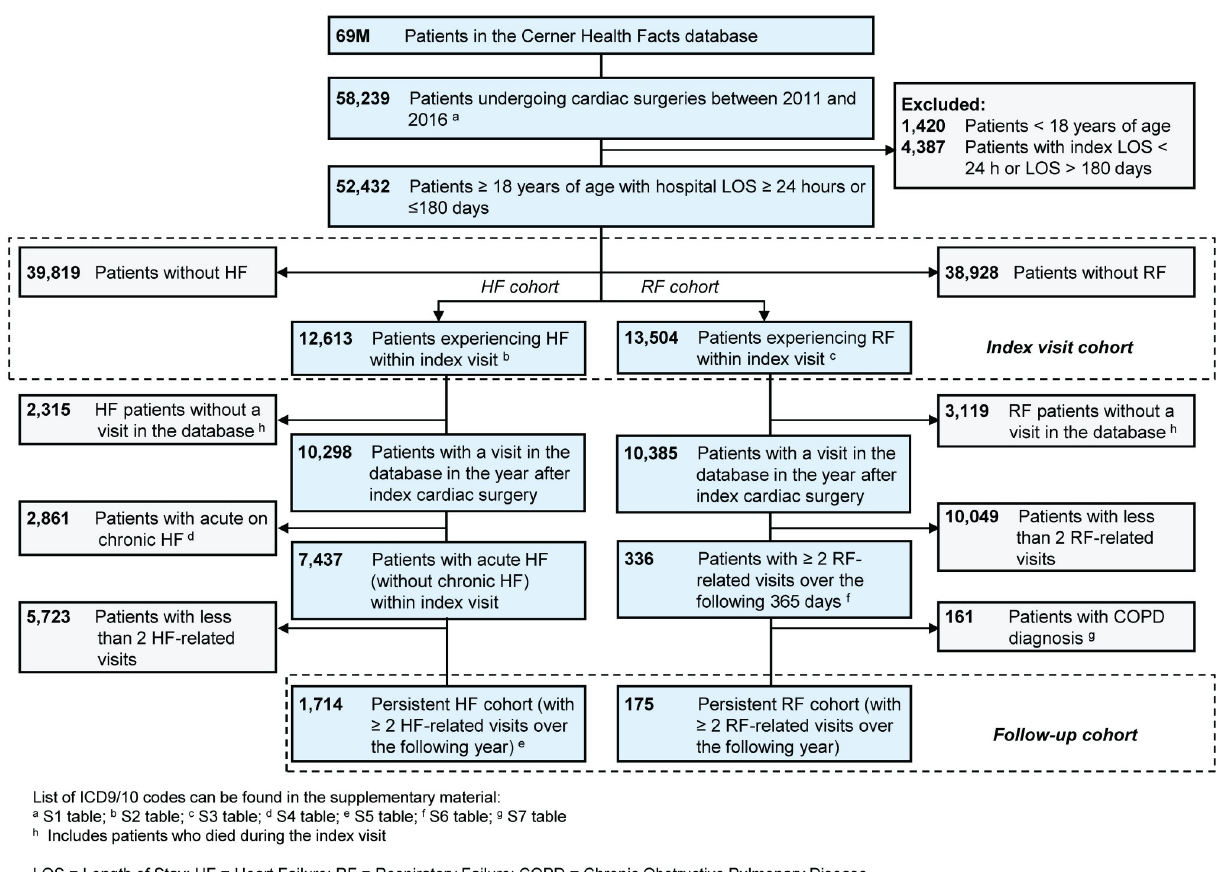
Fig 1. Patient selection and flow